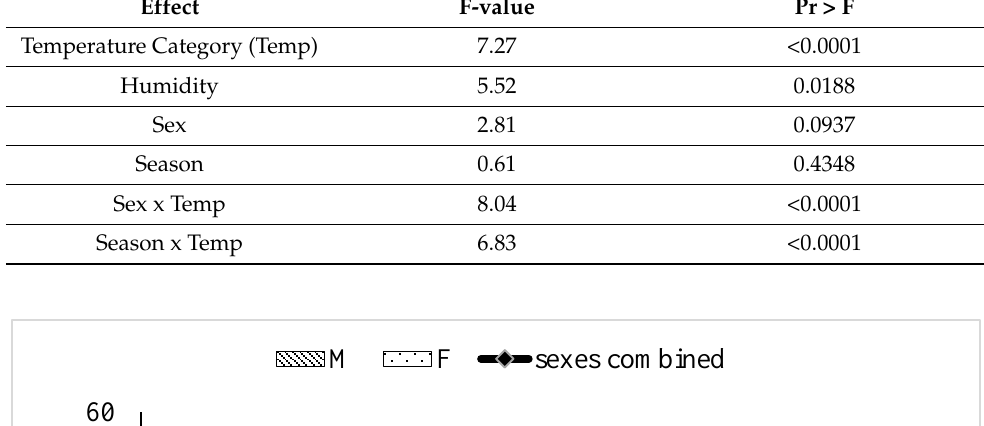
Table 3. Sub-analysis in Adult Polar Bears: Type III Tests of Fixed Effects.